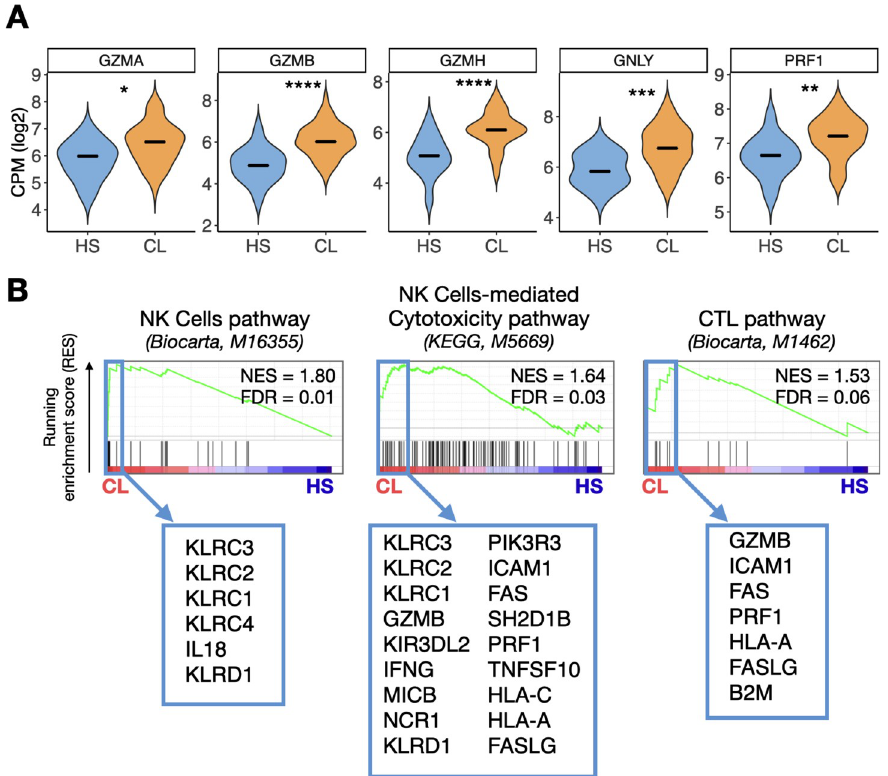
Fig 3. A cytotoxicity transcriptional signature is observed in the peripheral blood of patients infected with L . braziliensis . (A) Expression of genes encoding cytolytic granules ( GZMA , GZMB , GZMH , GNLY , and PRF1 ) in the peripheral blood of HS and CL patients. Wilcoxon rank-sum test was used for statistical analysis, � P < 0.05, �� P < 0.01, ��� P < 0.001 and ���� P < .0001. Gene expression is represented as counts per million (CPM) in log2 scale. (B) GSEA enrichment plots showing three cytotoxicity-related pathways from the Biocarta and KEGG Pathway Databases enriched in the CL peripheral blood relative to HS. Pathway name is indicated in parenthesis, next to the pathway database source. Light blue box indicates genes included in the Leading Edge subgroup from each pathway that were enriched and differentially expressed in CL relative to HS. Genes are shown in ranked order according to their running enrichment score. NES, normalized enrichment score; FDR, false discovery rate.